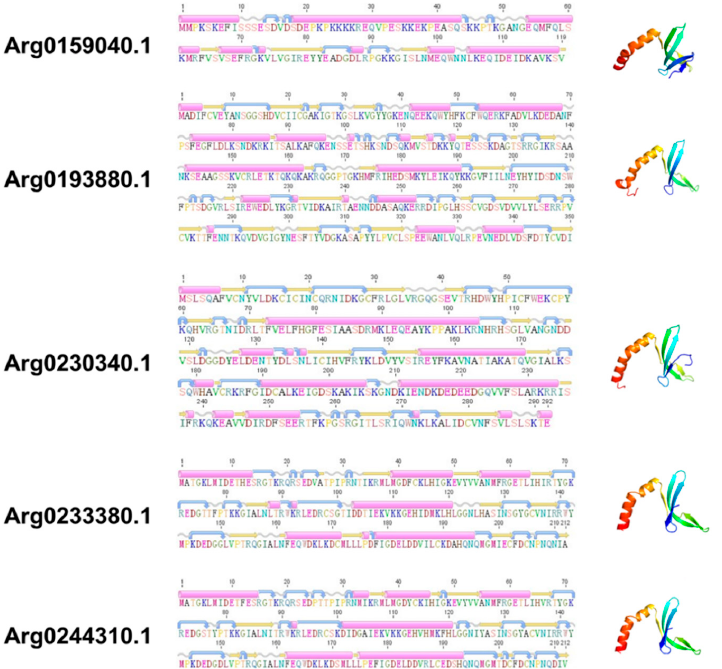
Figure 3. The secondary and tertiary structures of AiPC4s. The pink cylinders denote α helixes, the orange straight arrows indicate β strands, the wavy lines indicate coils, and the curved arrows indicate turns.